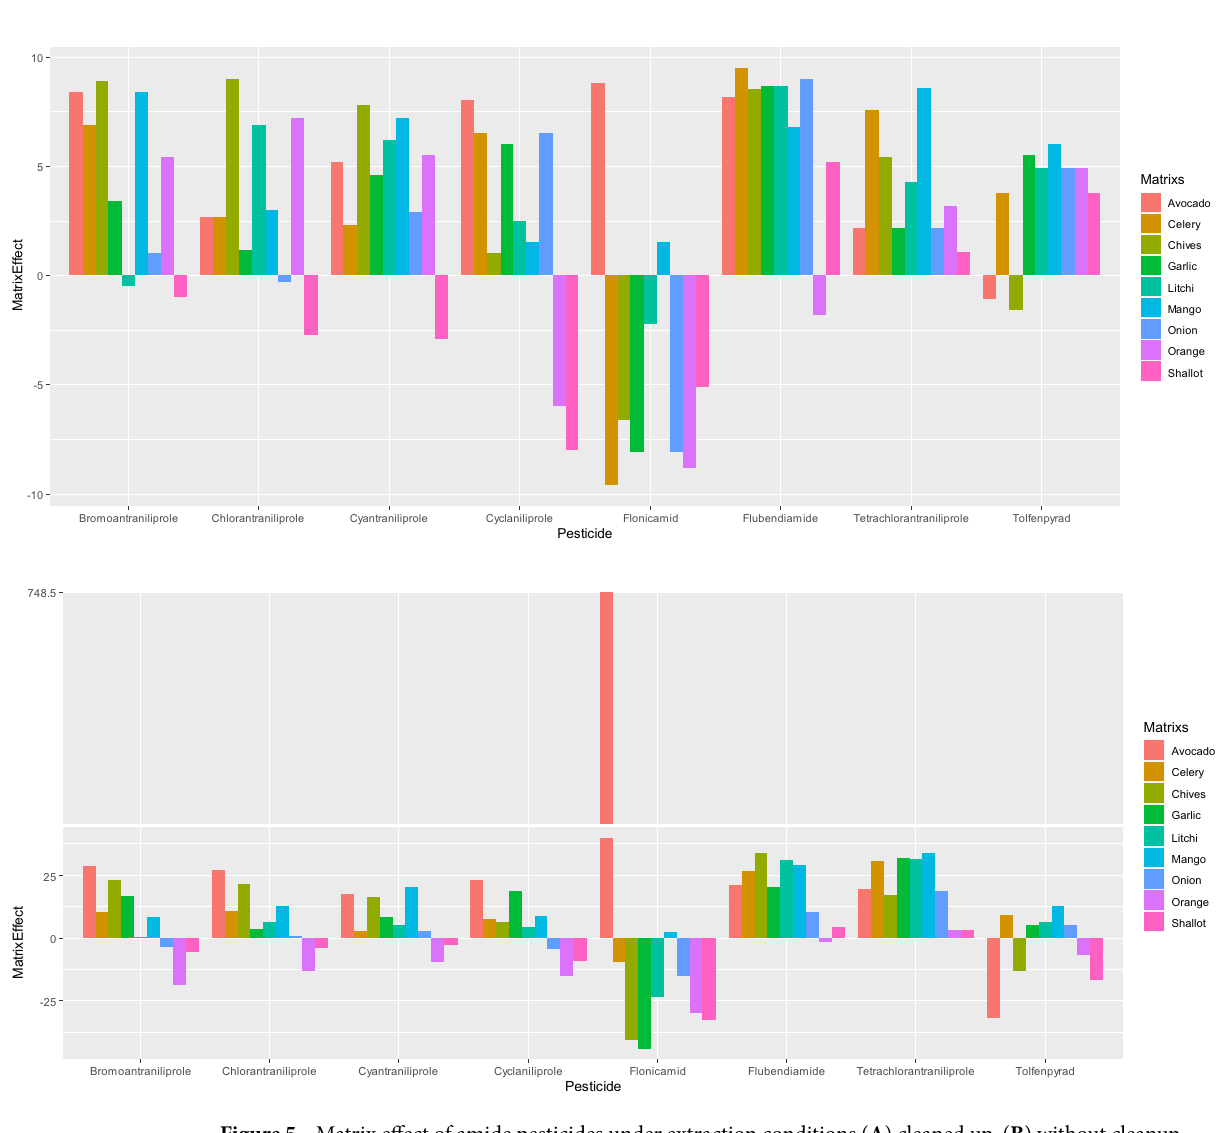
Figure 5. Matrix effect of amide pesticides under extraction conditions ( A ) cleaned up, ( B ) without cleanup.